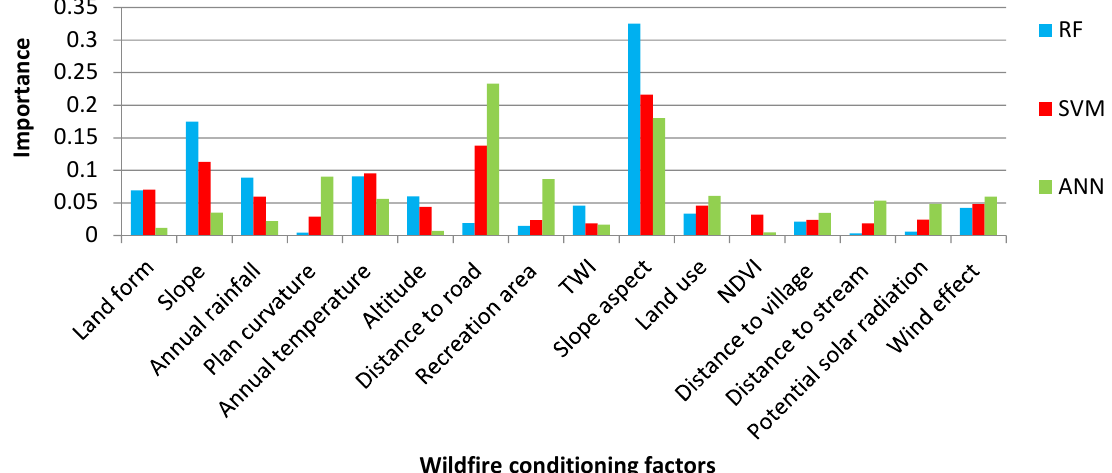
Figure 9. The estimated coefficient values for the wildfire conditioning factors by the applied machine learning (ML) models.